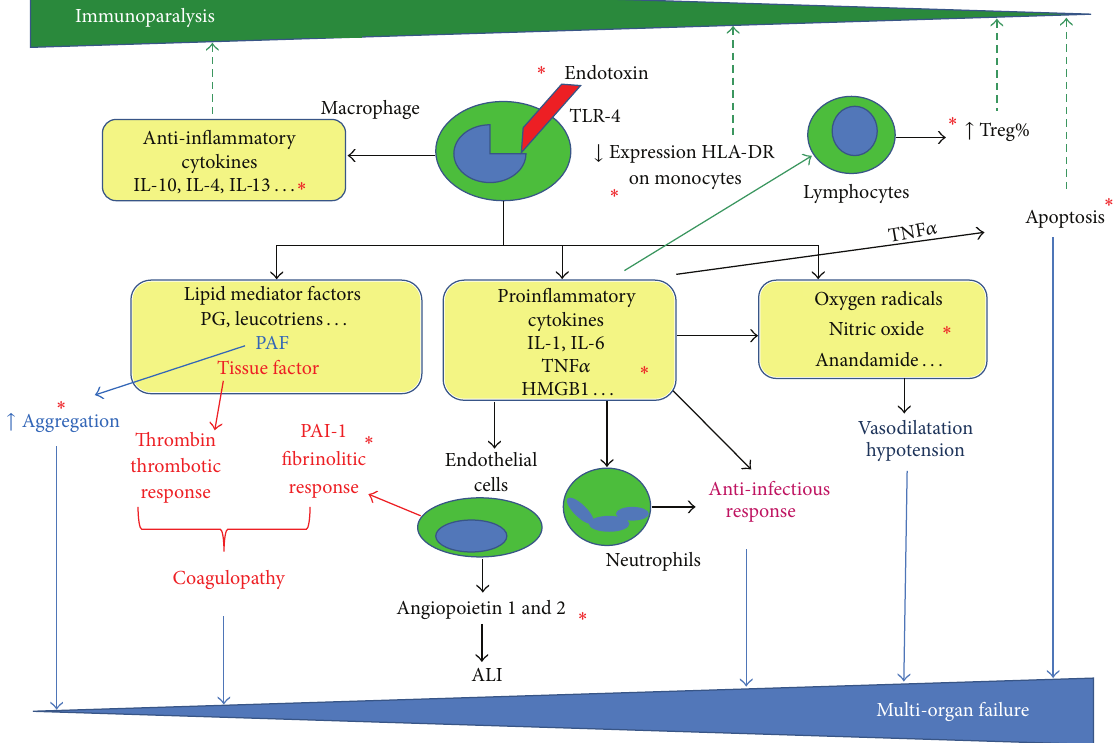
Figure 1: Proinflammatory and anti-inflammatory responses to endotoxin. Red asterisk: immunological mechanisms described for Poly- : T regulatory lymphocytes; TNF 𝛼 : tumor necrosis factor myxin-B hemoperfusion in this review; TLR: toll-like receptor; IL: interleukin; T reg alpha; HMGB1: high mobility group box protein 1; PAF: platelet activator factors; PAI: plasminogen activator inhibitor; ALI: acute lung